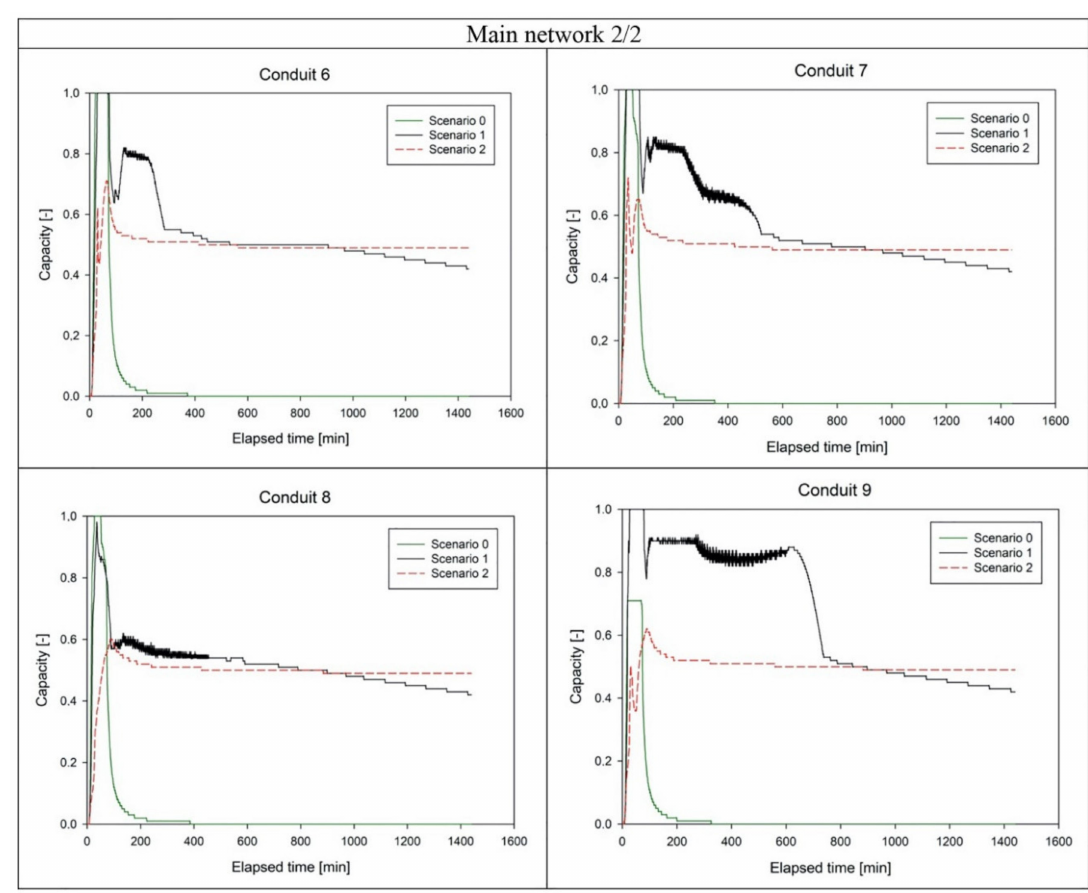
Figure A2. Conduits’ capacity in the main